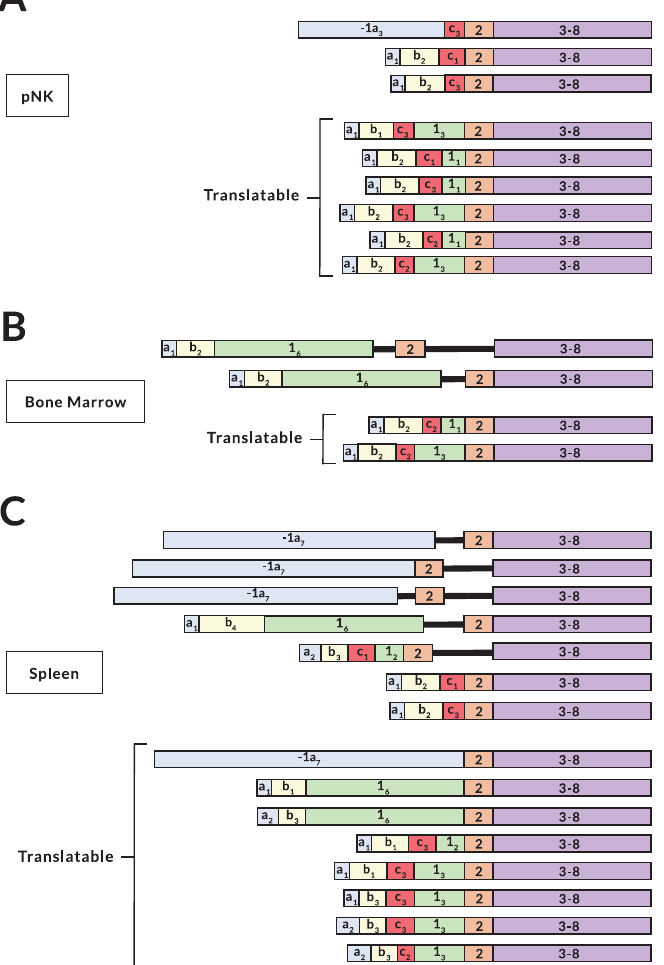
Fig 3. Full-length NK-Pro cDNAs identified in various human tissues. (A) Summary of full-length NK-Pro cDNAs cloned from peripheral blood NK cells (pNK) obtained from an individual homozygous for the HLA-C (cid:3) 06 allele. The lower group labeled (translatable) represents cDNAs that possess a complete HLA-C open reading frame. (B and C) Summary of clones identified from bone marrow or spleen cDNA generated from pooled human